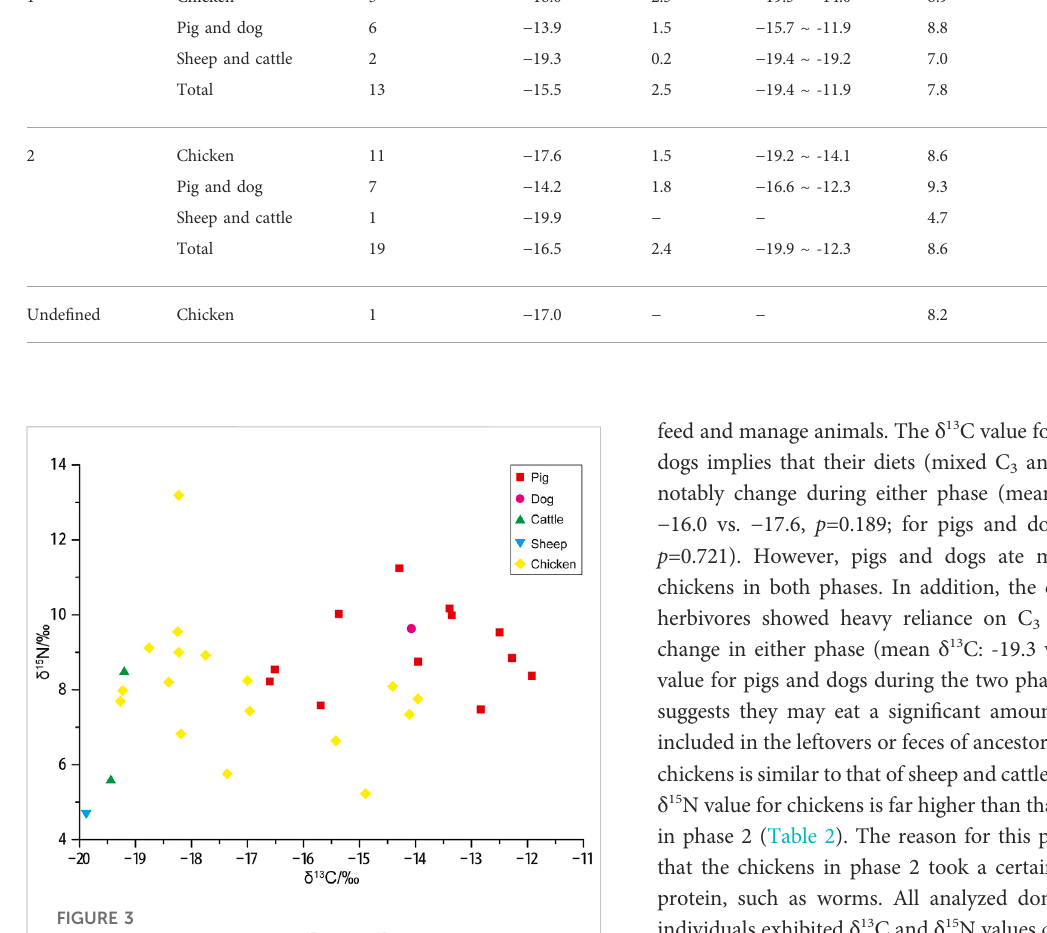
FIGURE 3 Scatter plots of bone collagen δ 13 C and δ 15 N values of animal samples from the HSG